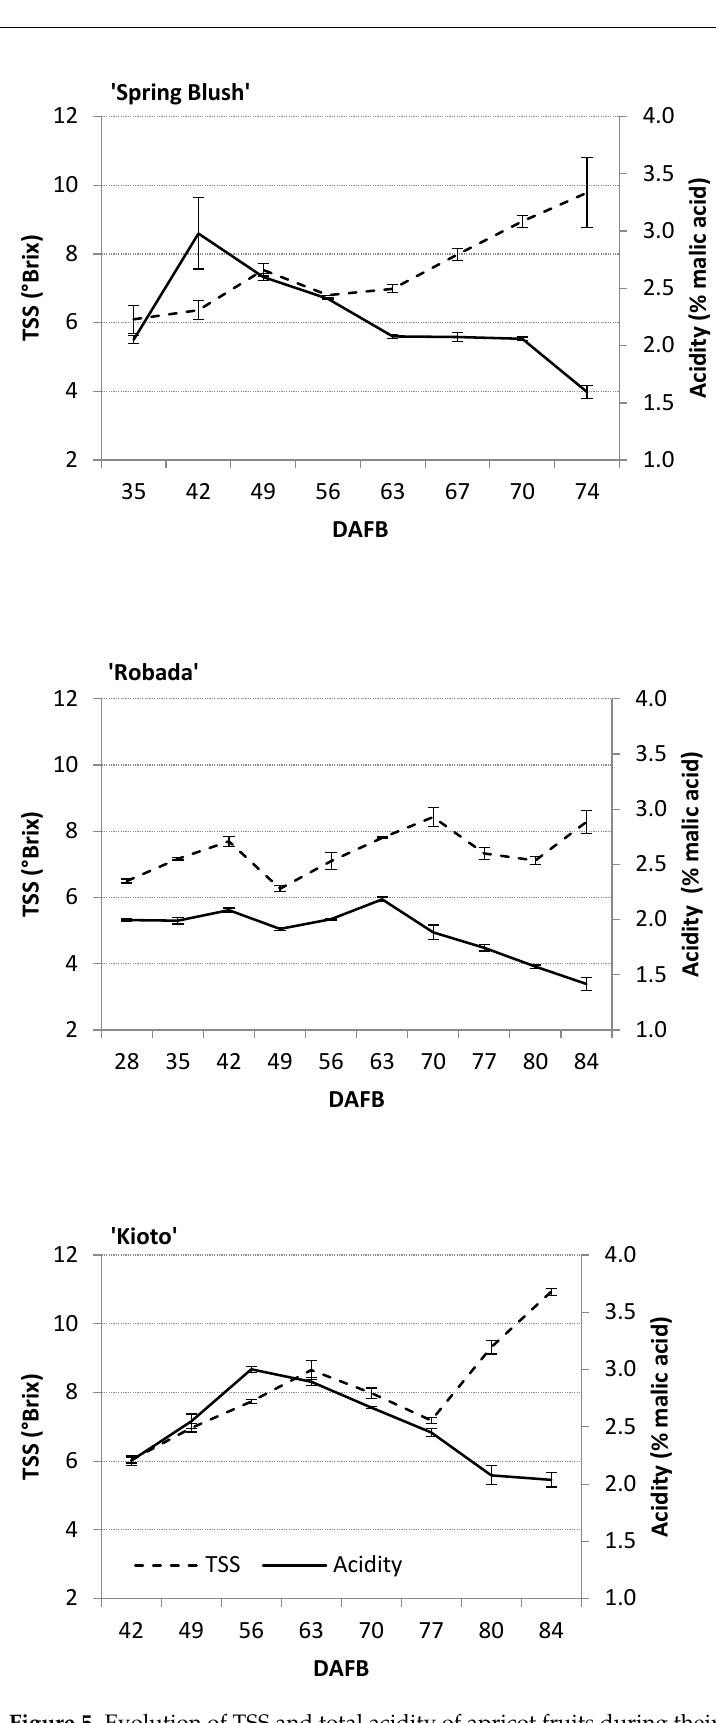
Figure 5. Evolution of TSS and total acidity of apricot fruits during their development and ripening on the tree. Mean values ± standard error (n =